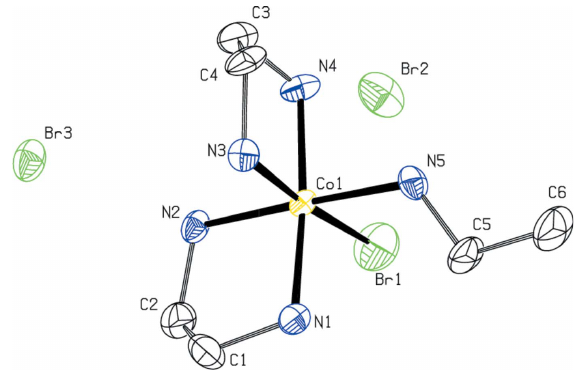
Figure 1 Molecular structure of the title compound, with atom labelling. Displacement ellipsoids are drawn at the 50% probability level. All H atoms